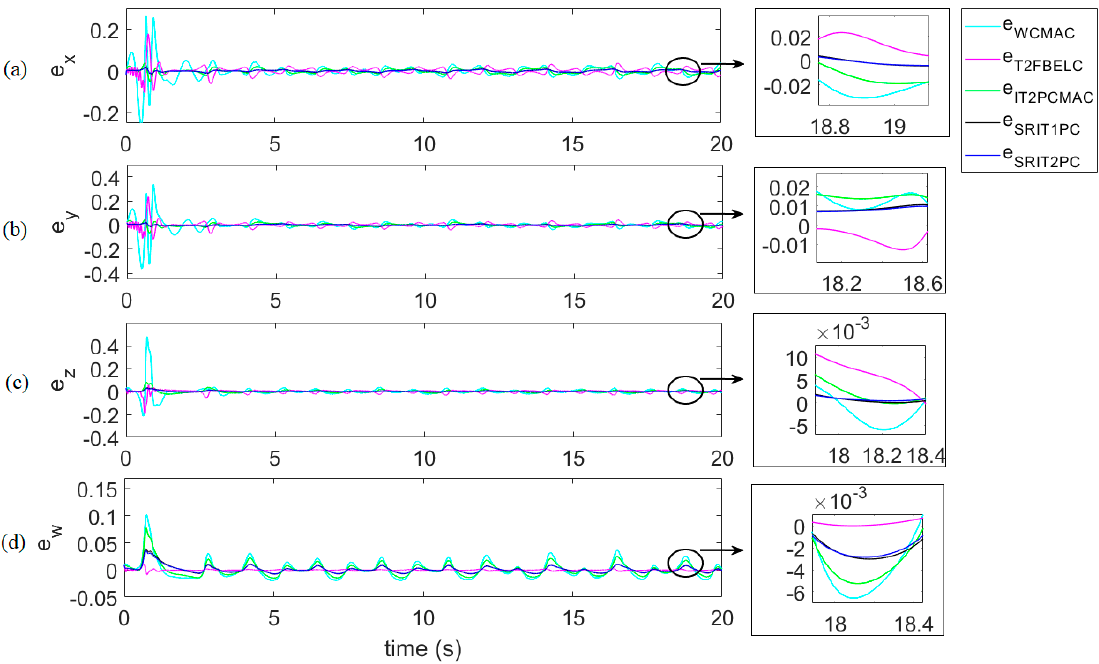
Figure 20. Tracking errors between the proposed SRIT2PC and other synchronization methods for Case 3: ( a ) e x , ( b ) e y , ( c ) e z , and ( d ) e w .